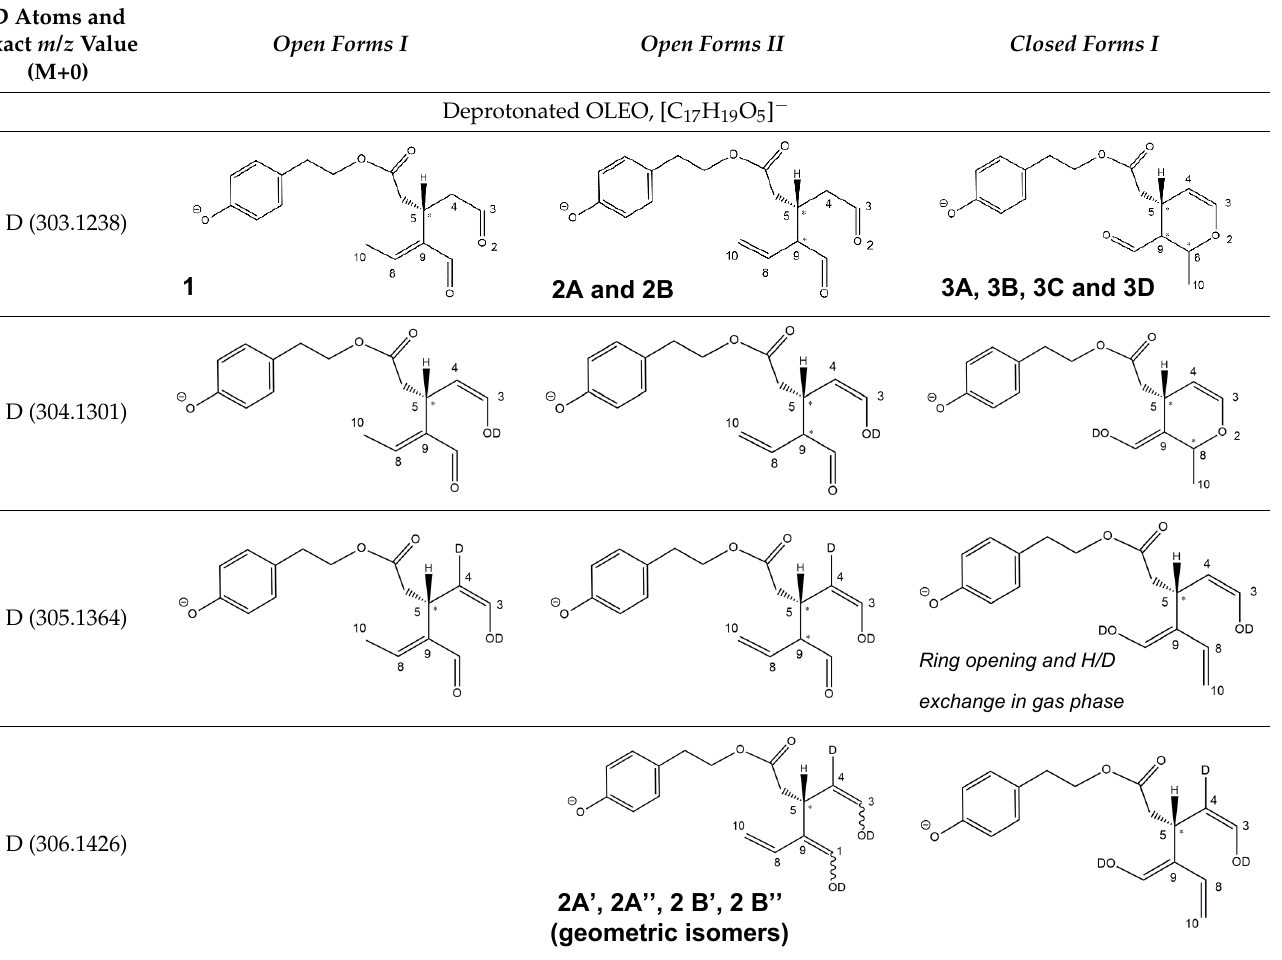
panel ( A )) and mono- (1 D, panel ( B )), bis- (2 D, panel ( C )), tris- (3 D, panel ( D )) and tetra- (4 D, panel ( E )) deuterated isoforms of OLEA, resulting from the HDX occurring during the RPLC-ESI(-)- FTMS analysis of an EVOO polar extract using D 2 O as co-solvent of acetonitrile in the mobile phase. The m / z intervals adopted for the extraction of ion currents are reported along with the normalization levels (NL). The proposed structure for each isoform is depicted in Table 1. Peak 4B corresponds to the major isoform of oleocanthalic acid, formed upon oxidative degradation of OLEO and isomeric with OLEA (see text for details). Table 1. Summary of the suggested structures for the anions of non ‐ deuterated oleocanthal (OLEO) Table 1. Summary of the suggested structures for the anions of non-deuterated oleocanthal (OLEO) Table 1. Summary of the suggested structures for the anions of non ‐ deuterated oleocanthal (OLEO) Table 1. Summary of the suggested structures for the anions of non ‐ deuterated oleocanthal (OLEO) Table 1. Summary of the suggested structures for the anions of non ‐ deuterated oleocanthal (OLEO) Table 1. Summary of the suggested structures for the anions of non ‐ deuterated oleocanthal (OLEO) Table 1. Summary of the suggested structures for the anions of non ‐ deuterated oleocanthal (OLEO) Table 1. Summary of the suggested structures for the anions of non ‐ deuterated oleocanthal (OLEO) Table 1. Summary of the suggested structures for the anions of non ‐ deuterated oleocanthal (OLEO) and oleacin (OLEA) isoforms and for the corresponding deuterated derivatives detected upon H/D Table 1. Summary of the suggested structures for the anions of non ‐ deuterated oleocanthal (OLEO) Table 1. Summary of the suggested structures for the anions of non ‐ deuterated oleocanthal (OLEO) Table 1. Summary of the suggested structures for the anions of non ‐ deuterated oleocanthal (OLEO) and oleacin (OLEA) isoforms and for the corresponding deuterated derivatives detected upon H/D and oleacin (OLEA) isoforms and for the corresponding deuterated derivatives detected upon H/D and oleacin (OLEA) isoforms and for the corresponding deuterated derivatives detected upon H/D and oleacin (OLEA) isoforms and for the corresponding deuterated derivatives detected upon H/D and oleacin (OLEA) isoforms and for the corresponding deuterated derivatives detected upon H/D and oleacin (OLEA) isoforms and for the corresponding deuterated derivatives detected upon H/D and oleacin (OLEA) isoforms and for the corresponding deuterated derivatives detected upon H/D and oleacin (OLEA) isoforms and for the corresponding deuterated derivatives detected upon H/D and oleacin (OLEA) isoforms and for the corresponding deuterated derivatives detected upon H/D exchange during RPLC ‐ ESI ‐ FTMS analysis of an EVOO extract. The number of D atoms introduced and oleacin (OLEA) isoforms and for the corresponding deuterated derivatives detected upon H/D and oleacin (OLEA) isoforms and for the corresponding deuterated derivatives detected upon H/D exchange during RPLC ‐ ESI ‐ FTMS analysis of an EVOO extract. The number of D atoms introduced exchange during RPLC ‐ ESI ‐ FTMS analysis of an EVOO extract. The number of D atoms introduced exchange during RPLC-ESI-FTMS analysis of an EVOO extract. The number of D atoms introduced exchange during RPLC ‐ ESI ‐ FTMS analysis of an EVOO extract. The number of D atoms introduced exchange during RPLC ‐ ESI ‐ FTMS analysis of an EVOO extract. The number of D atoms introduced exchange during RPLC ‐ ESI ‐ FTMS analysis of an EVOO extract. The number of D atoms introduced exchange during RPLC ‐ ESI ‐ FTMS analysis of an EVOO extract. The number of D atoms introduced exchange during RPLC ‐ ESI ‐ FTMS analysis of an EVOO extract. The number of D atoms introduced in each case and the exact m / z value of the corresponding M+0 isotopologue are reported in the first exchange during RPLC ‐ ESI ‐ FTMS analysis of an EVOO extract. The number of D atoms introduced exchange during RPLC ‐ ESI ‐ FTMS analysis of an EVOO extract. The number of D atoms introduced exchange during RPLC ‐ ESI ‐ FTMS analysis of an EVOO extract. The number of D atoms introduced in each case and the exact m / z value of the corresponding M+0 isotopologue are reported in the first in each case and the exact m / z value of the corresponding M+0 isotopologue are reported in the first in each case and the exact m / z value of the corresponding M+0 isotopologue are reported in the first in each case and the exact m / z value of the corresponding M+0 isotopologue are reported in the first in each case and the exact m / z value of the corresponding M+0 isotopologue are reported in the first in each case and the exact m / z value of the corresponding M+0 isotopologue are reported in the first in each case and the exact m / z value of the corresponding M+0 isotopologue are reported in the first in each case and the exact m / z value of the corresponding M+0 isotopologue are reported in the first column. Isoform numerical labels are the same adopted in Figures 5 and 6 for OLEO and OLEA, in each case and the exact m / z value of the corresponding M+0 isotopologue are reported in the first in each case and the exact m / z value of the corresponding M+0 isotopologue are reported in the first in each case and the exact m / z value of the corresponding M+0 isotopologue are reported in the first column. Isoform numerical labels are the same adopted in Figures 5 and 6 for OLEO and OLEA, column. Isoform numerical labels are the same adopted in Figures 5 and 6 for OLEO and OLEA, column. Isoform numerical labels are the same adopted in Figures 5 and 6 for OLEO and OLEA, column. Isoform numerical labels are the same adopted in Figures 5 and 6 for OLEO and OLEA, column. Isoform numerical labels are the same adopted in Figures 5 and 6 for OLEO and OLEA, column. Isoform numerical labels are the same adopted in Figures 5 and 6 for OLEO and OLEA, column. Isoform numerical labels are the same adopted in Figures 5 and 6 for OLEO and OLEA, column. Isoform numerical labels are the same adopted in Figures 5 and 6 for OLEO and OLEA, column. Isoform numerical labels are the same adopted in Figures 5 and 6 for OLEO and OLEA, respectively. column. Isoform numerical labels are the same adopted in Figures 5 and 6 for OLEO and OLEA, column. Isoform numerical labels are the same adopted in Figures 5 and 6 for OLEO and OLEA, respectively. respectively. respectively. respectively. respectively. respectively. respectively. respectively. The chiral center on C5 and the stereogenic center on C9 are marked by an asterisk. respectively. respectively.